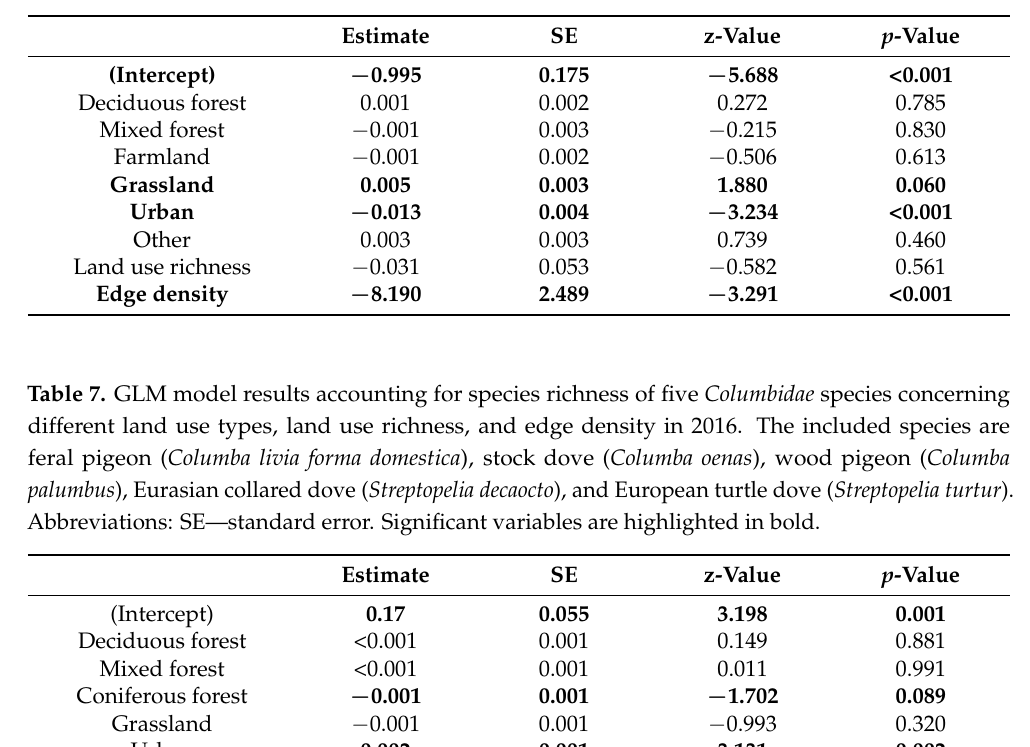
Table 6. GLM model results accounting for the presence and absence of species European turtle dove ( Streptopelia turtur ) concerning different land use types, land use richness, and edge density in 2016. Abbreviations: SE—standard error. Significant variables are highlighted in bold.